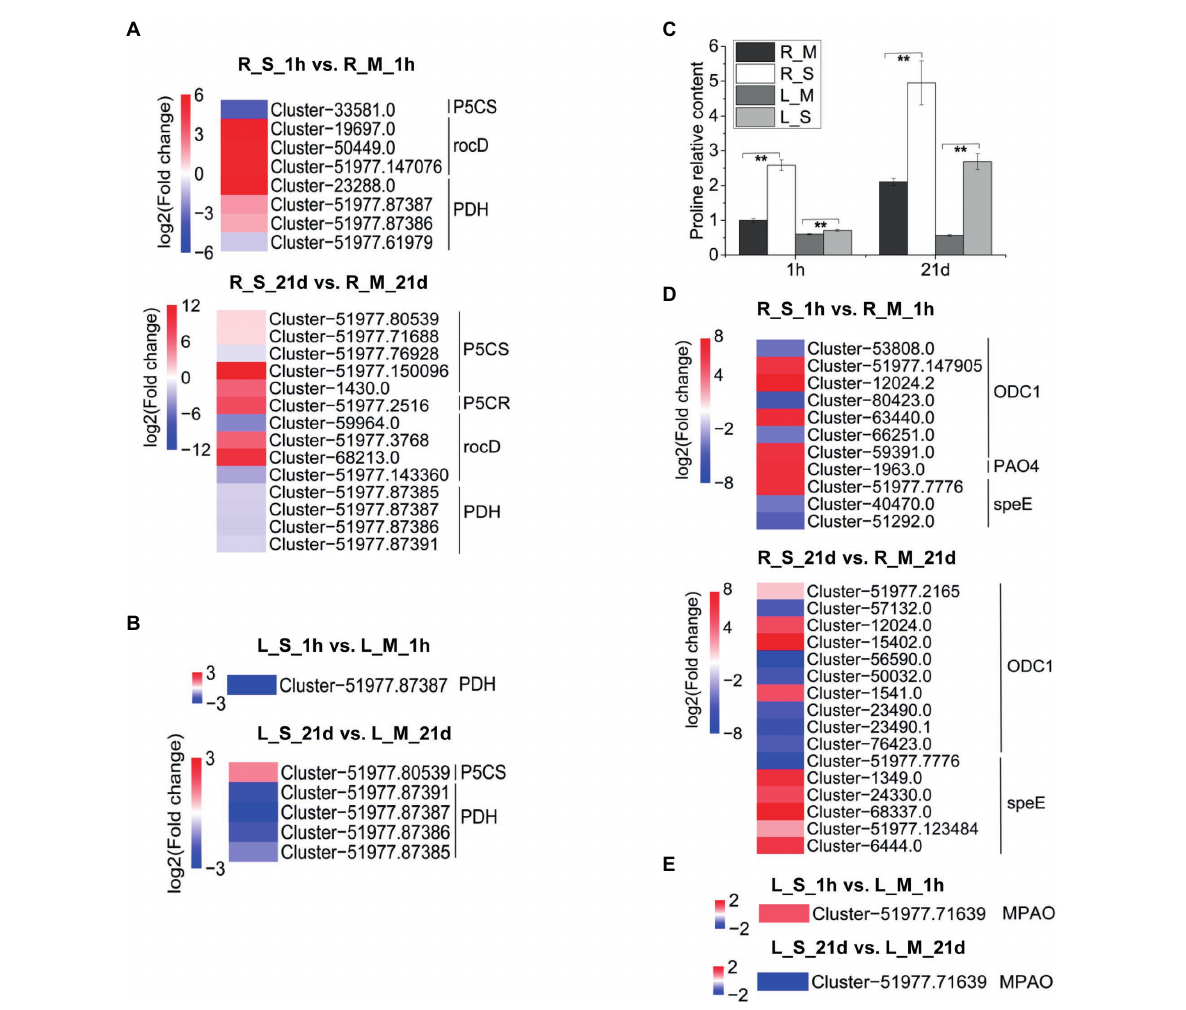
FIGURE 7 Expression analysis of DEGs involved in proline metabolism. (A) Expression analysis of DEGs in S. portulacastrum roots involved in proline metabolism after 1 h (R_S_1h vs. R_M_1h) and 21 days (R_S_21d vs. R_M_21d) of salt treatment (400 mM Na). (B) Expression analysis of DEGs in S. portulacastrum leaves involved in proline metabolism after 1 h (L_S_1h vs. L_M_1h) and 21 days (L_S_21d vs. L_M_21d) of salt treatment. (C) The relative content of proline in roots and leaves compared to the R_M sample. R_M and L_M mean roots and leaves under control condition. R_S and L_S mean roots and leaves under salt stress. The error bars were calculated from three biological replicates. Mean separation was based on Tukey HSD test at p < 0.01 (**) levels. (D,E) Expression analysis of DEGs in S. portulacastrum roots and leaves respectively involved in polyamines metabolism after 1 h and 21 days of salt